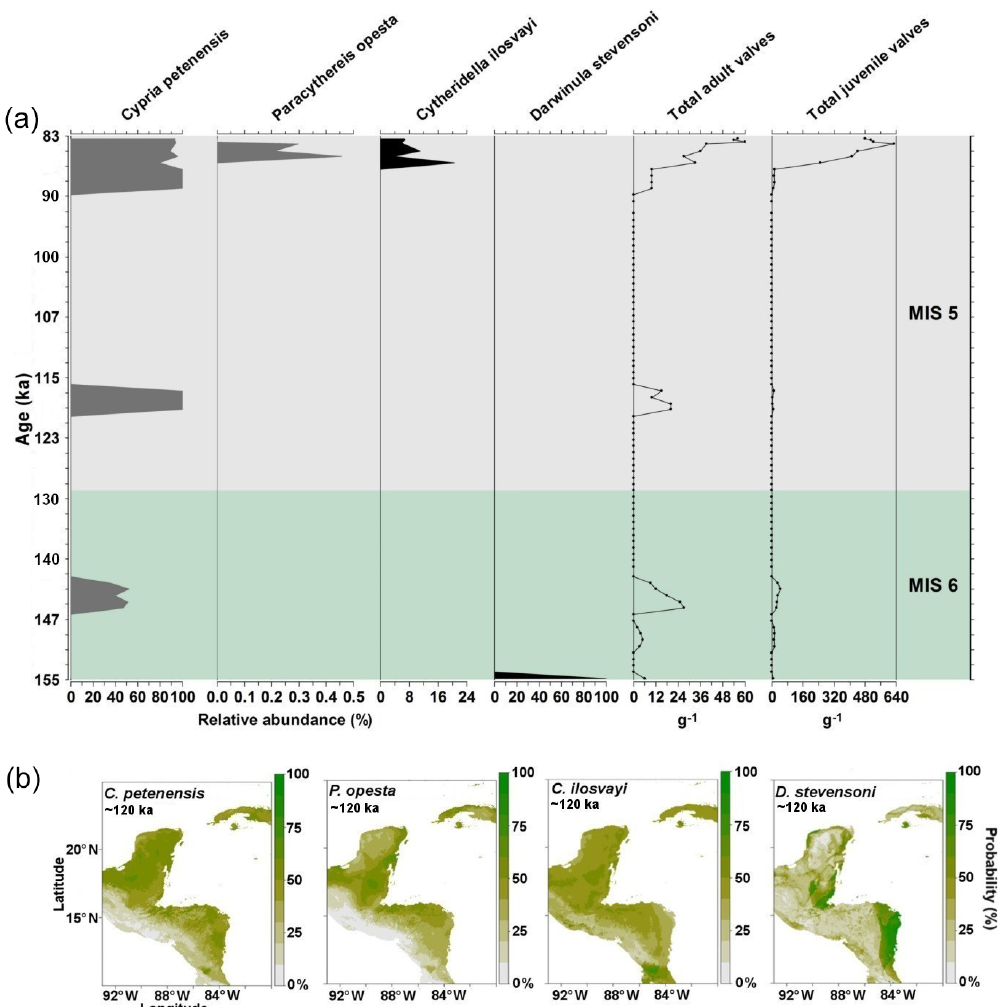
Figure 3. Fossil record of the period 155–83ka and species niche modelling results for ∼ 120ka (representing last interglacial climate) for four ostracode species: Cypria petenensis , Paracythereis opesta , Cytheridella ilosvayi and Darwinula stevensoni . (a) Fossil record of four ostracode species from core PI-1 in Lake Petén Itzá, and (b) maps from niche modelling, showing the probability of species